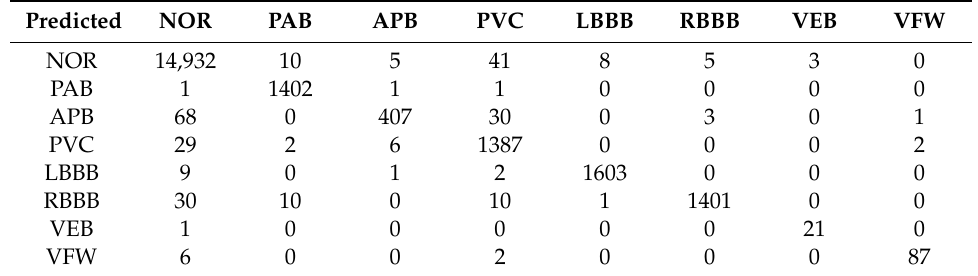
Figure 6. Accuracy and loss of VGGNet training model. Table 6. Confusion matrix of the VGGNet model.